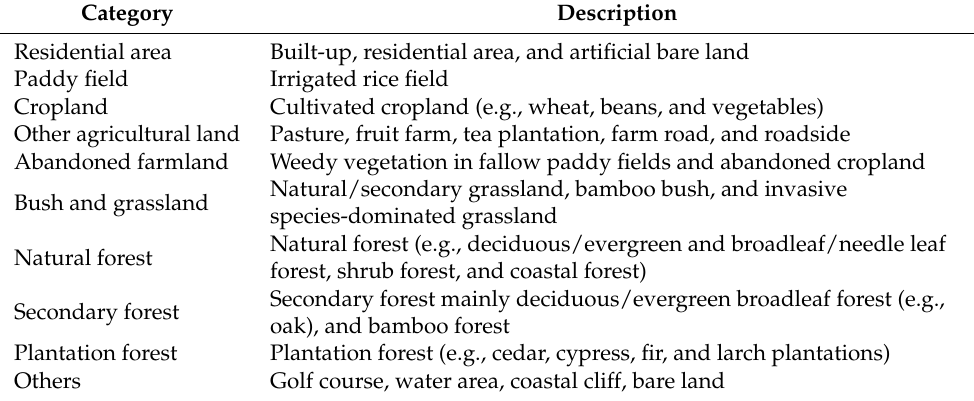
Table 1. Land-use categories for the Predicting and Assessing Natural Capital and Ecosystem Services (PANCES)